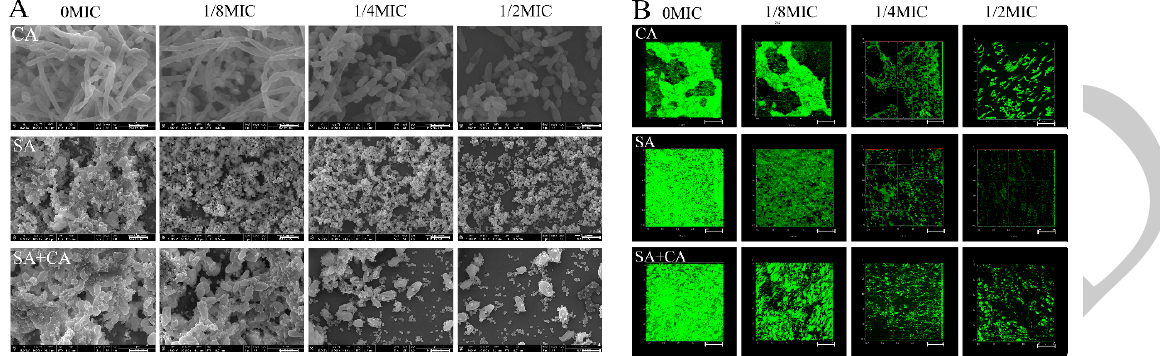
Figure 2. Inhibitory effects of sub-MIC chelerythrine on C. albicans (CA) and S. aureus (SA) mono- and dual-culture (SA + CA) biofilms, shown in field emission scanning electron microscopy (FESEM, ( A )) and confocal laser scanning microscopy images (CLSM, ( B )). Scale bars represent 5 µ m for FESEM and 10 μ m for CLSM, respectively.